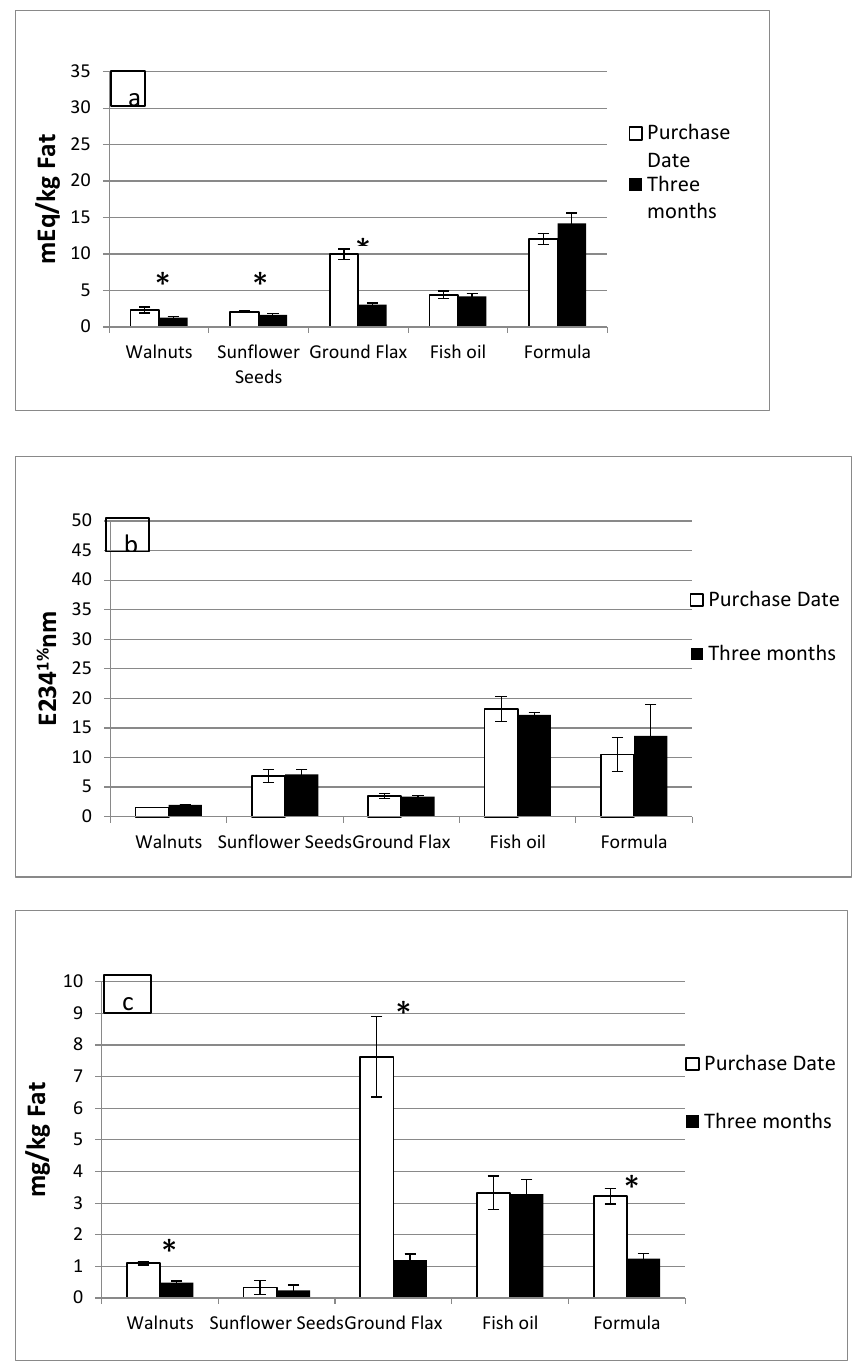
Figure 2. Products of lipid oxidation in room-temperature foods. Mean ± SEM of the peroxide value ( a ), conjugated dienes ( b ), and aldehydes ( c ) in room-temperature foods (RTF) on the purchase date (white bars) and after three months (black bars). Mean differences between the two time points were compared with the Mann–Whitney U test. * p ≤ 0.05.